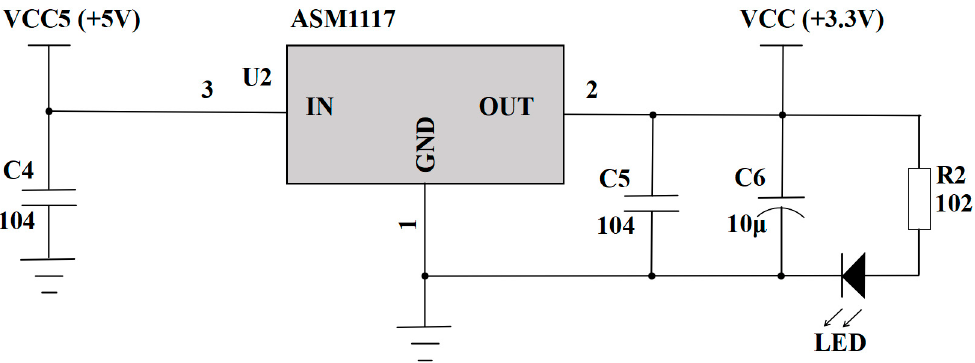
Figure 3. The connections and circuits of MSP430F149.